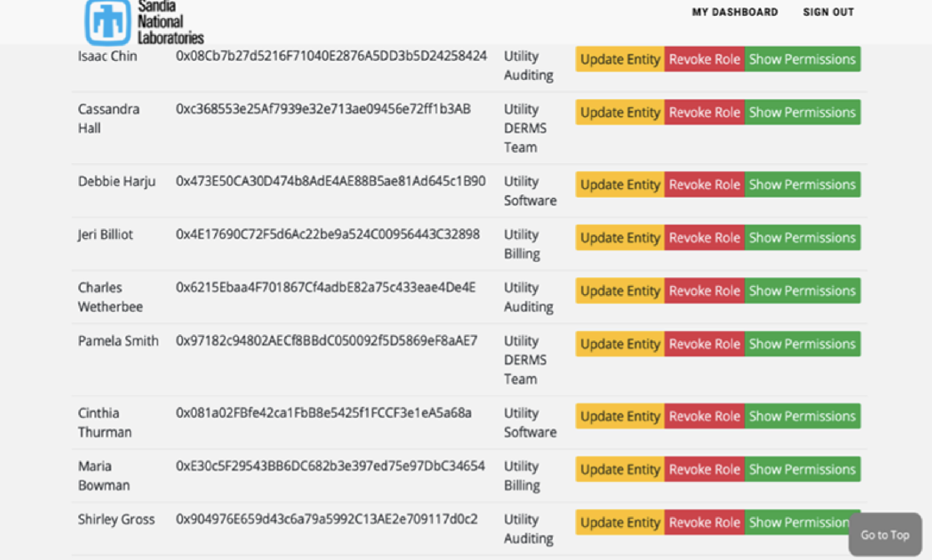
Figure 5. Ethereum Blockchain GUI: The user chooses a Utility or a Service Provider company to perform CRUD operations to the associated